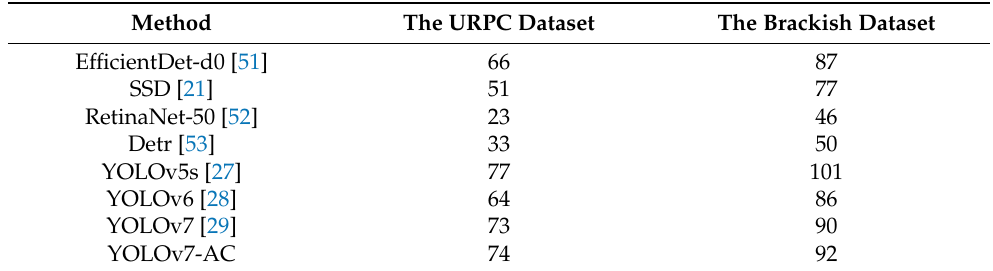
Table 8. Target detection model FPS comparison of the URPC dataset and the Brackish